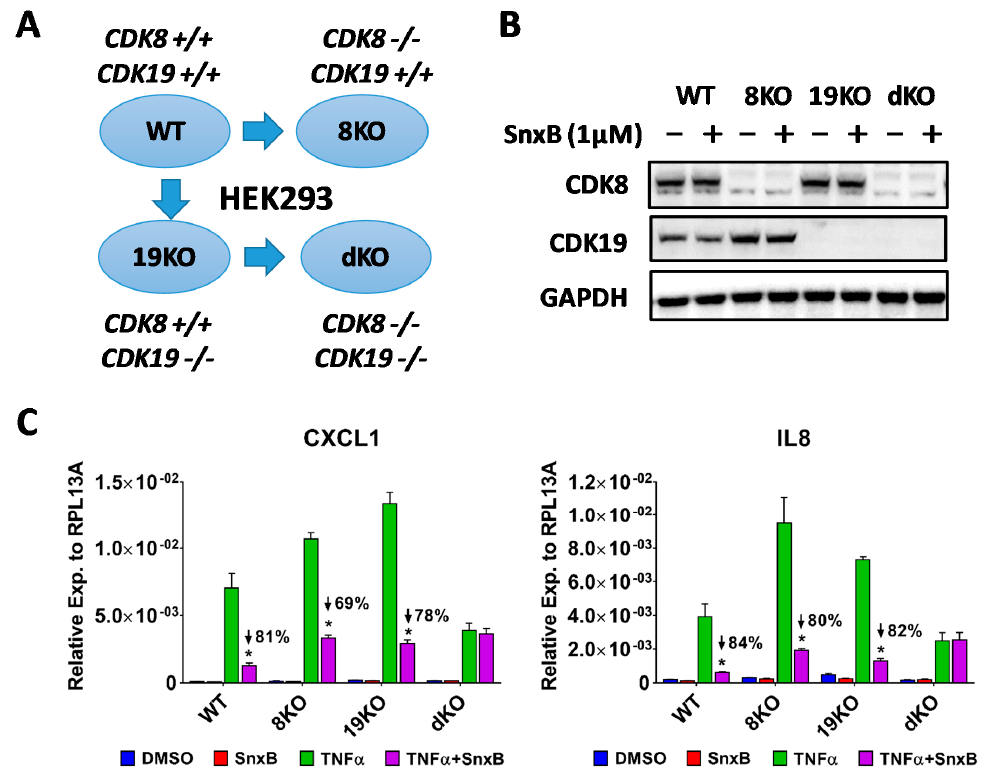
Figure 1. ( A ) Schematic of generating CDK8/19 single- and double-knockout derivatives of 293 cells. ( B ) Western blot analysis of CDK8 and CDK19 expression in 293 cells and their knockout derivatives in the absence or presence of senexin B (3 h treatment). ( C ) Effects of TNF α and senexin B on the